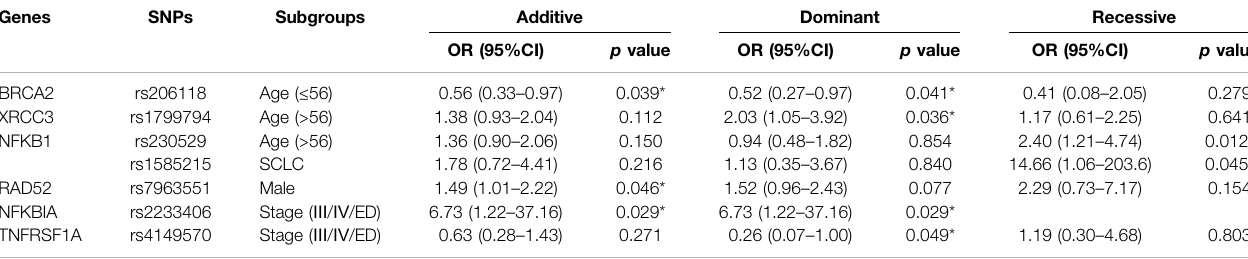
TABLE 5 | Strati fi cation analyses of Association between the seven polymorphisms and PFS in lung cancer patients. Genes SNPs